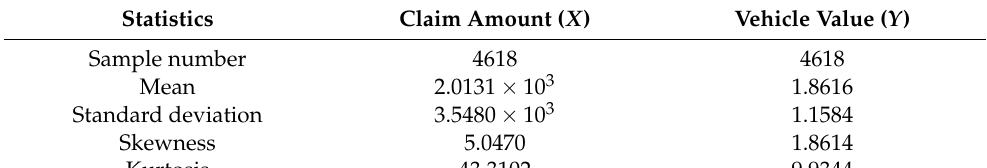
Table 1. Descriptive statistics.